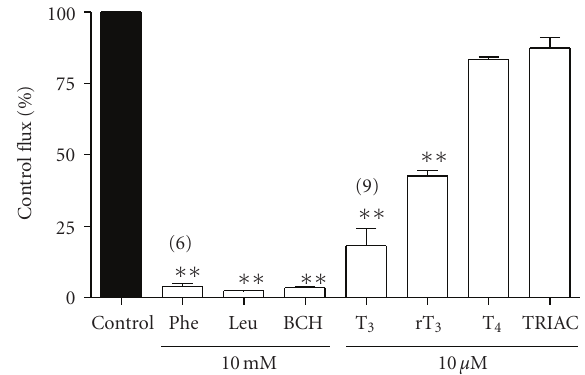
Figure 2: E ff ect of amino acids and iodothyronines on uptake of phenylalanine into 3T3-L1 adipocytes. [ 3 H]phenylalanine uptake was measured at 5 μ M over 3 minutes in the absence (control) or presence of 10 μ M iodothyronine or 10mM amino acid in the uptake bu ff er. Values are expressed ± SEM of 3 measurements (except where indicated) as % of the control flux. ∗∗ P < . 01; value significantly di ff erent from control using Dunnett’s Multiple Comparison